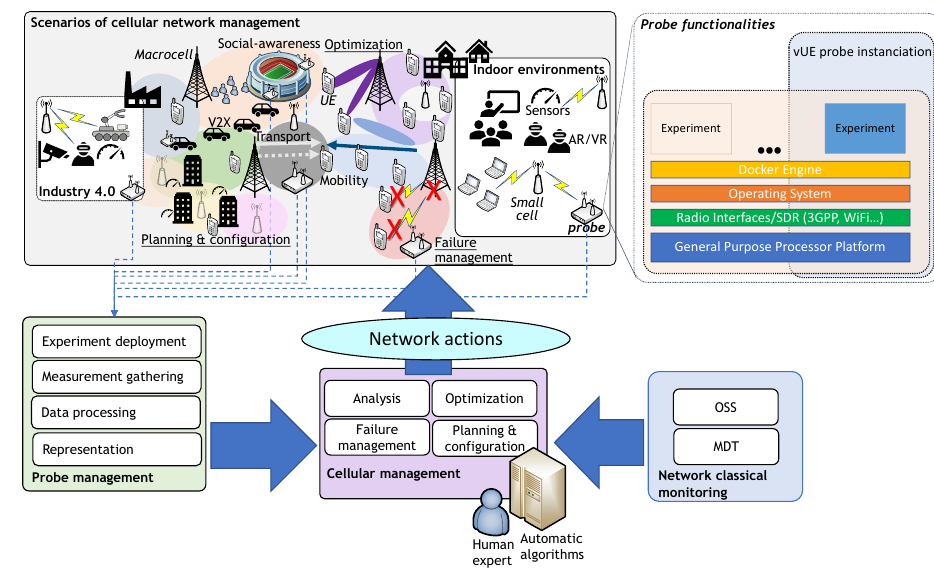
Figure 1. A high level diagram of the vUE probe